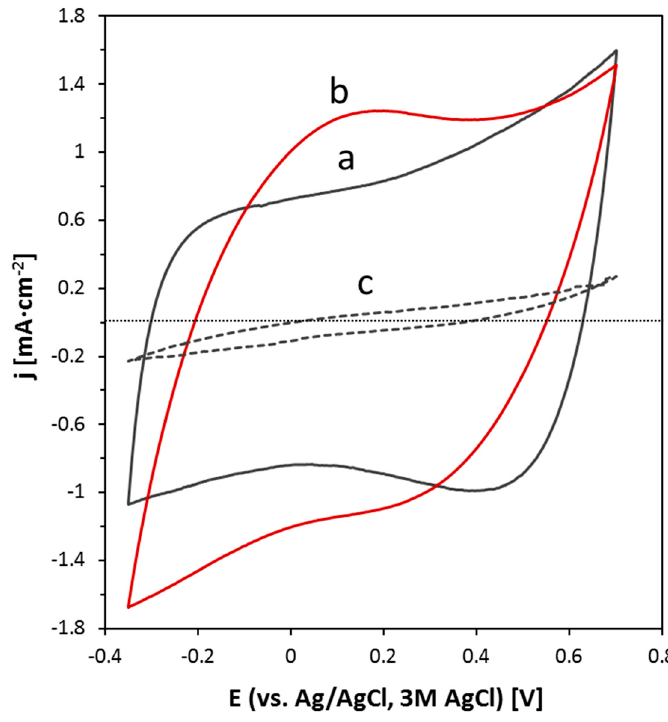
Figure 4. Cyclic voltammograms after 10 cycles in 0.1M Na 2 SO 4 at 100 mV/s of three electrodes: ( a ) MSH-0; ( b ) MSH-1; and ( c )